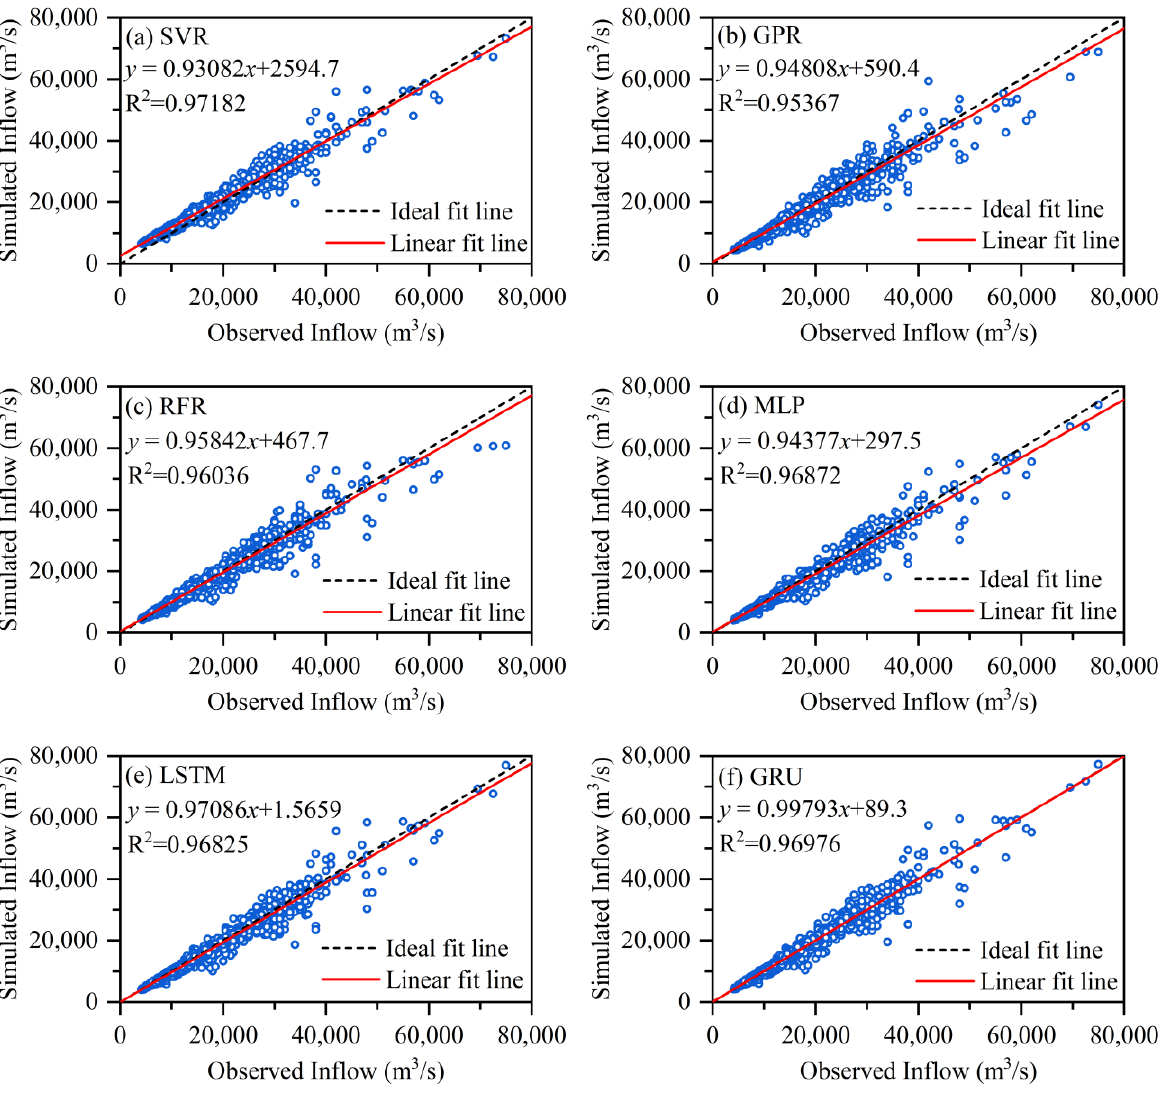
Figure 4. The scatter plots of the simulated and observed inflows of the TGR by different ML models during the testing period.